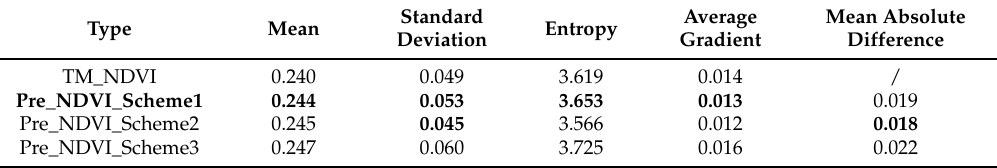
Table 4. Accuracy assessment of the fused images. TM_NDVI is the observed TM NDVI image and Pre_NDVI represents the predicted NDVI images at 30-m resolution that were derived from STARFM with Schemes 1, 2, and 3. Numbers in bold represent the best fit among the three schemes.